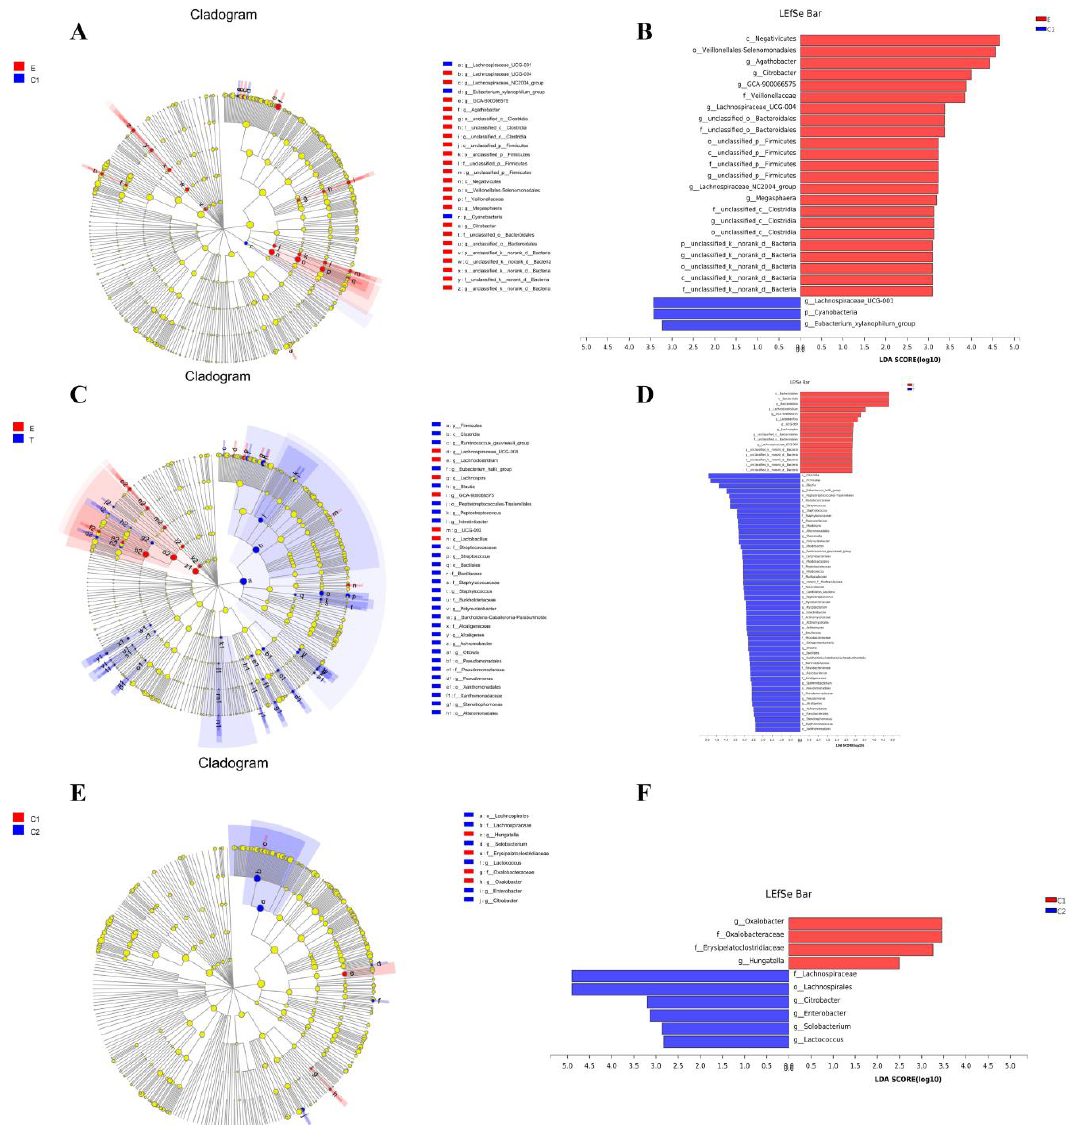
Figure 4. LEfSe analysis of the difference in the abundance of the gut microbiota in each group. ( A , C , E ) Cladograms showing the taxonomic hierarchy of the main taxa from the phylum to genus (from inner to outer) in the sample community. ( B , D , F ) LDA score showing the abundance of different taxa in the intestinal flora between the groups. LEfSe: linear discriminant analysis effect size; LDA: linear discriminant analysis; E: experimental group before exercise intervention; T: experimental group after exercise intervention; C1: control group before exercise intervention; C2: control group after exercise